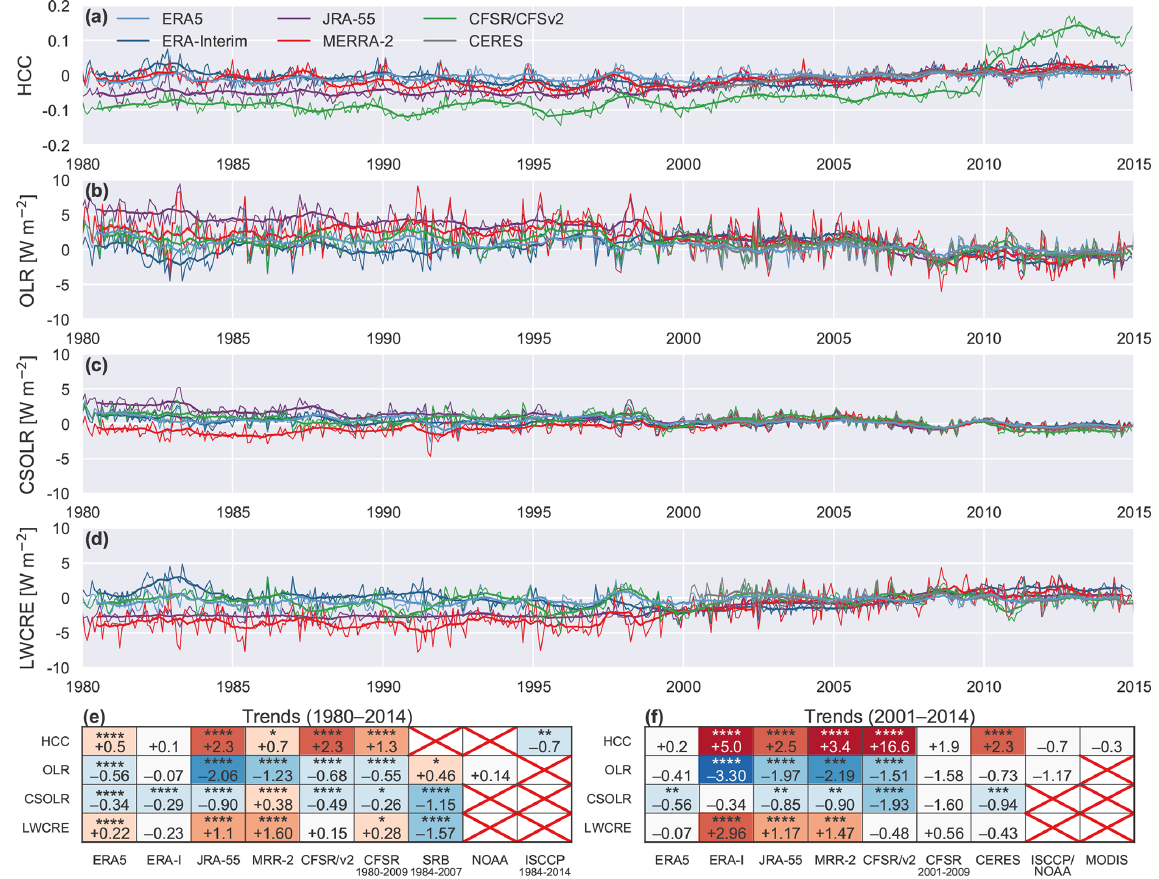
Figure 14. Time series of deseasonalized anomalies in monthly-mean (a) HCC, (b) all-sky OLR, (c) clear-sky OLR (CSOLR), and (d) LWCRE averaged over the inner tropics (10 ◦ S–10 ◦ N) for 1980–2014 based on ERA5 (cyan), ERA-Interim (blue), JRA-55 (purple), MERRA-2 (red), and CFSR/CFSv2 (green). Observational analyses from CERES SYN1Deg ( a ; March 2000–December 2014) and CERES EBAF ( b–d ; March 2000–December 2014) are shown for context. Anomalies are calculated relative to the mean annual cycle during 2001– 2014. Thick lines show time series after applying a 12-month uniformly weighted rolling mean. Trends are listed for annual-mean anomalies during the (e) 1980–2014 and (f) 2001–2014 periods in percentage points per decade for HCC and units of watts per square metre per decade for OLR, clear-sky OLR, and LWCRE (in which ERA-Interim is abbreviated ERA-I and CFSR/CFSv2 is abbreviated CFSR/v2). Stars in- dicate statistical significance at the 90% ( ∗ ), 95% ( ∗∗ ), 99% ( ∗∗∗ ), and 99.5% ( ∗∗∗∗ ) confidence levels. Light-grey shading indicates that the 90% confidence interval of the Theil–Sen slope (Sen, 1968) contains zero. Blue colours mark negative trends and red colours positive trends, with darker shades signifying larger trend magnitudes (0 to 1, 1 to 2, 2 to 3, and greater than